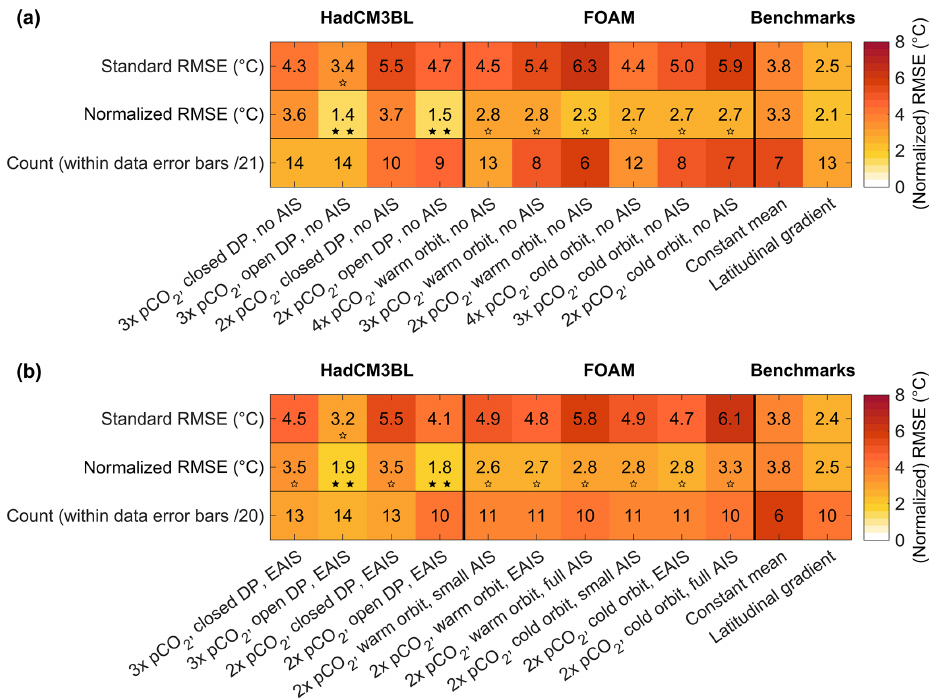
Figure 4. Standard RMSE ( ◦ C), normalized RMSE ( ◦ C) and count metric for the annual mean temperature from all model simulations and the benchmarks compared against the late Eocene dataset (a) and the early Oligocene dataset (b) . Labels on the x axis refer to the p CO 2 level (2 × , 3 × or 4 × pre-industrial levels), the state of the Drake Passage (DP) in HadCM3BL simulations and the size of the Antarctic Ice Sheet (AIS). The colour scale of the count metric is normalized to match that of the RMSE metrics (i.e. white indicates the best: all sites are within error bars; dark orange indicates the worst: no sites are within error bars). For a given metric, single open stars indicate simulations with moderate performance, and double black stars indicate simulations with good